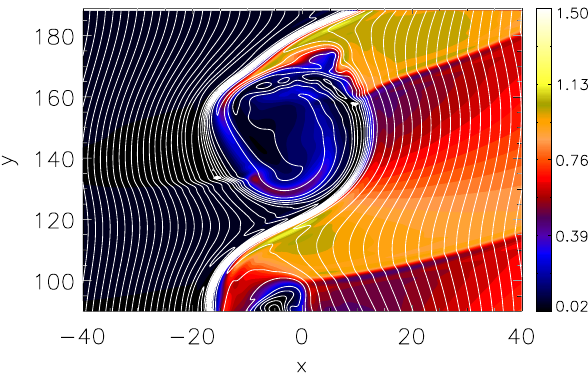
Fig. 2. Shaded density isocontours at t = 156, V 0 = 6. White curves represent magnetic field lines in the (x,y)-plane.